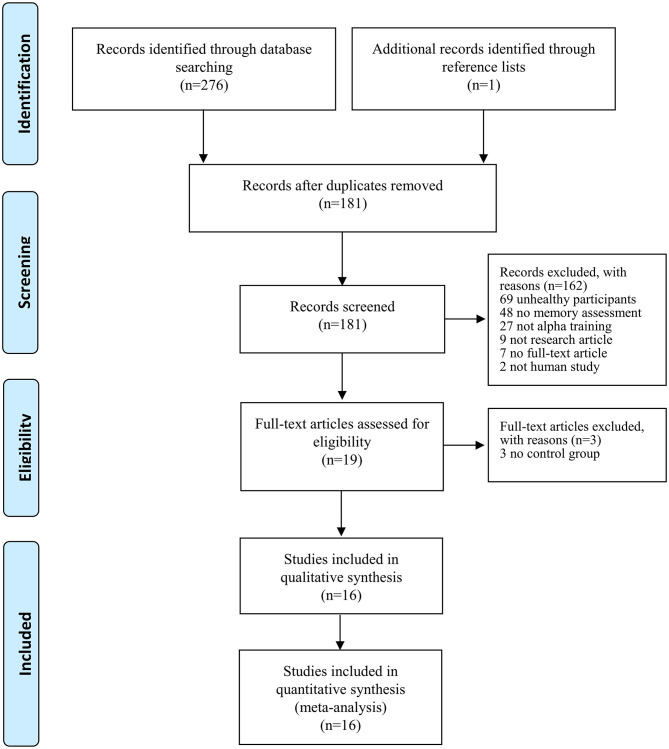
The Preferred Reporting Items for Systematic Reviews and Meta-Analyses (PRISMA) flow diagram presenting the literature searches and the included studies.